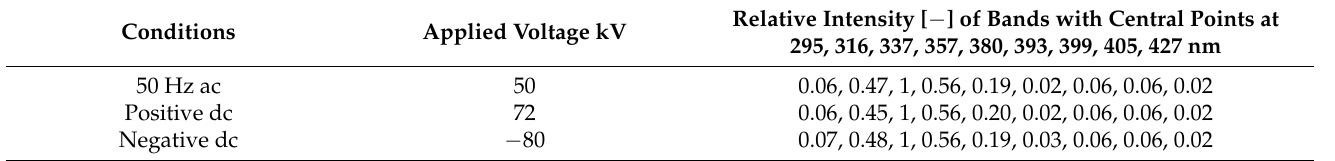
Table 1. Experimental corona conditions with a needle-plane gap (diameter = 3.5 mm, gap = 150 mm), main spectral bands and their relative intensities.